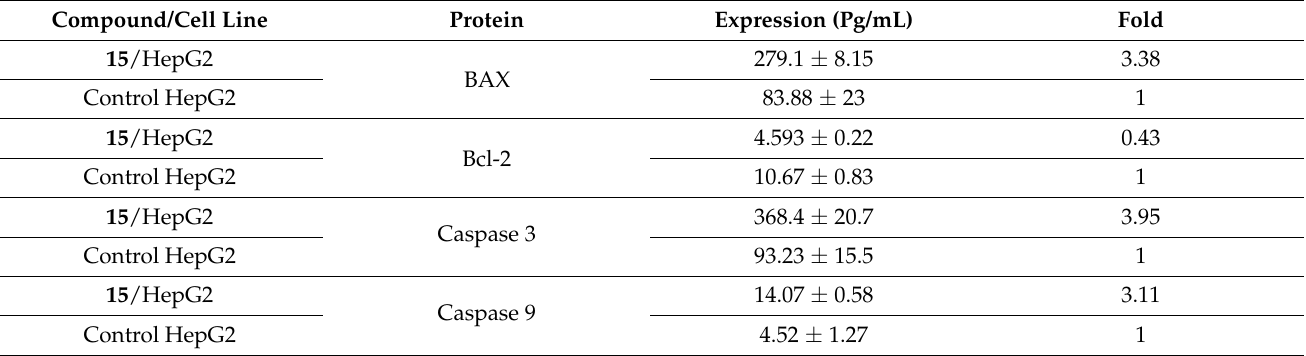
Table 5. Effect of compound 15 on protein expression of Bax, Bcl-2, Caspase 3 and Caspase